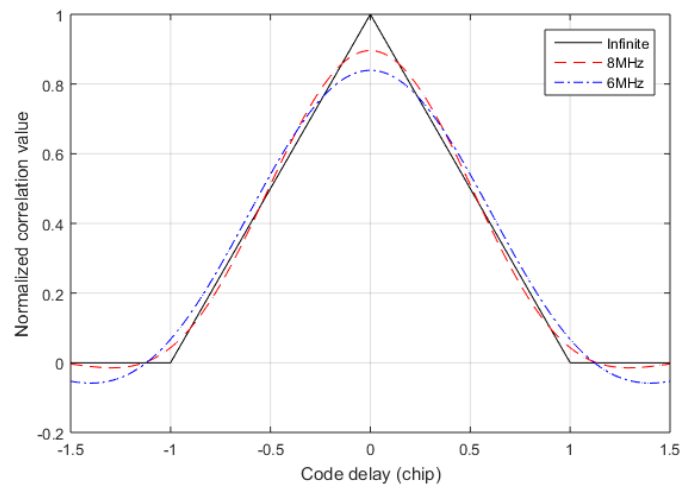
Figure 6. The autocorrelation function under different bandwidths.